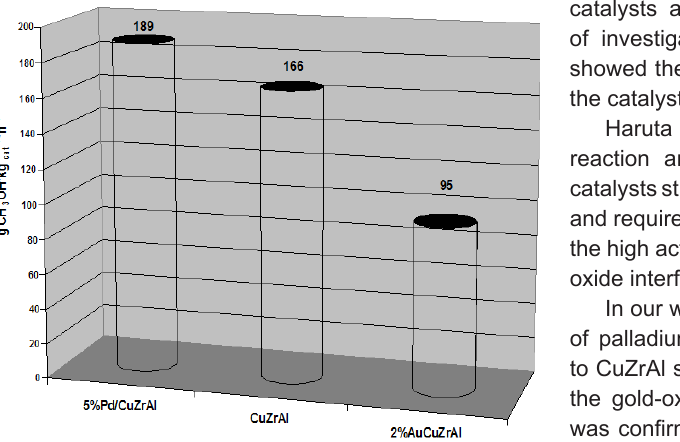
Table 3. The activity results for methanol synthesis from CO/H Catalyst